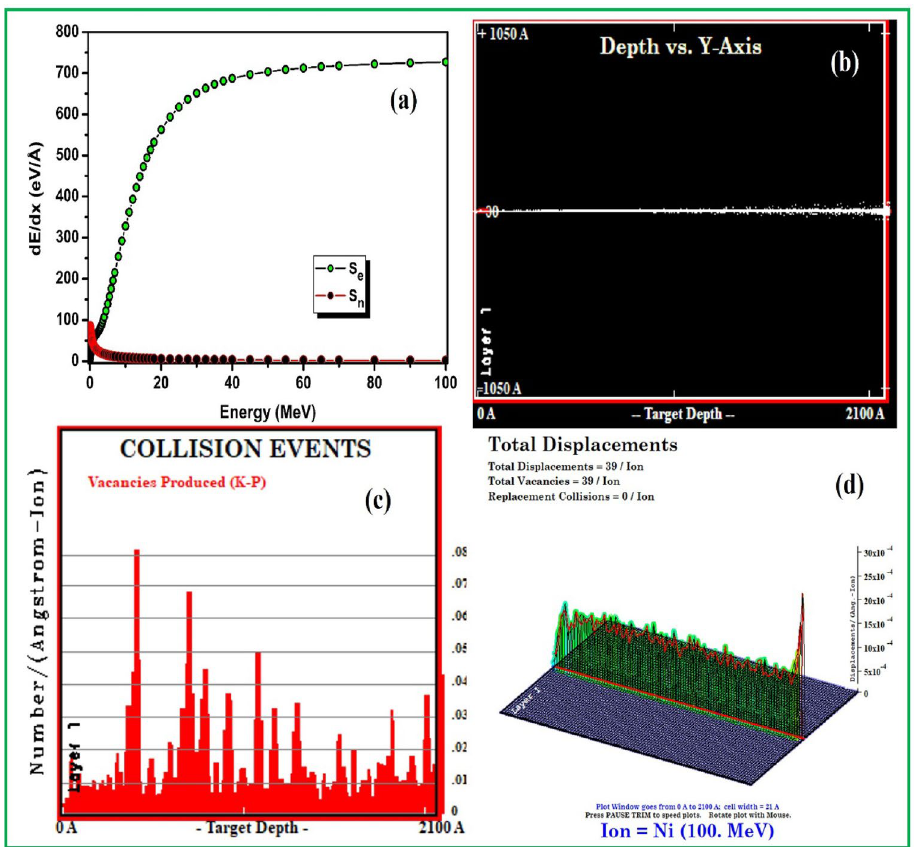
Figure 1. The S e and S n profile ( a ) Ni 7+ ion beam in ZrO 2 thin films, detailed calculation with full damage cascade ( b ) depth vs. Y-axis ( c ) collision events and ( d ) Target displacement 3D respectively for Ni ion